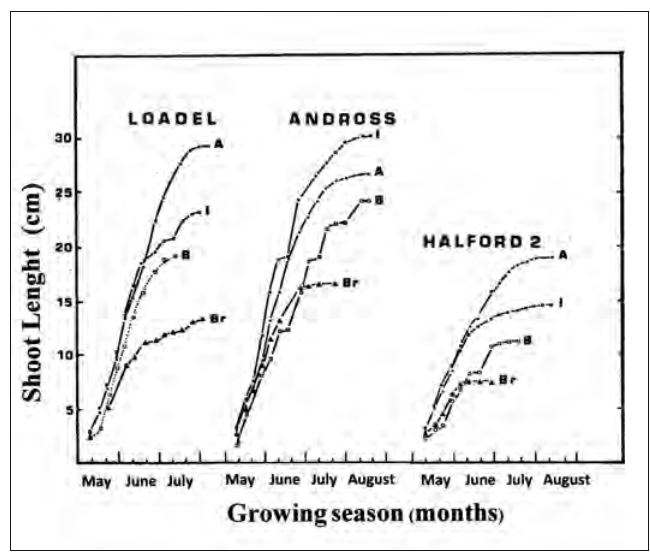
Fig. 13 - Elongation in apical (A), sub-apical (B, I) long shoots and in brindle (Br) shoots of three cultivars of peach tree with differ - ent ripening time (Giulivo et al ., 1981 a).